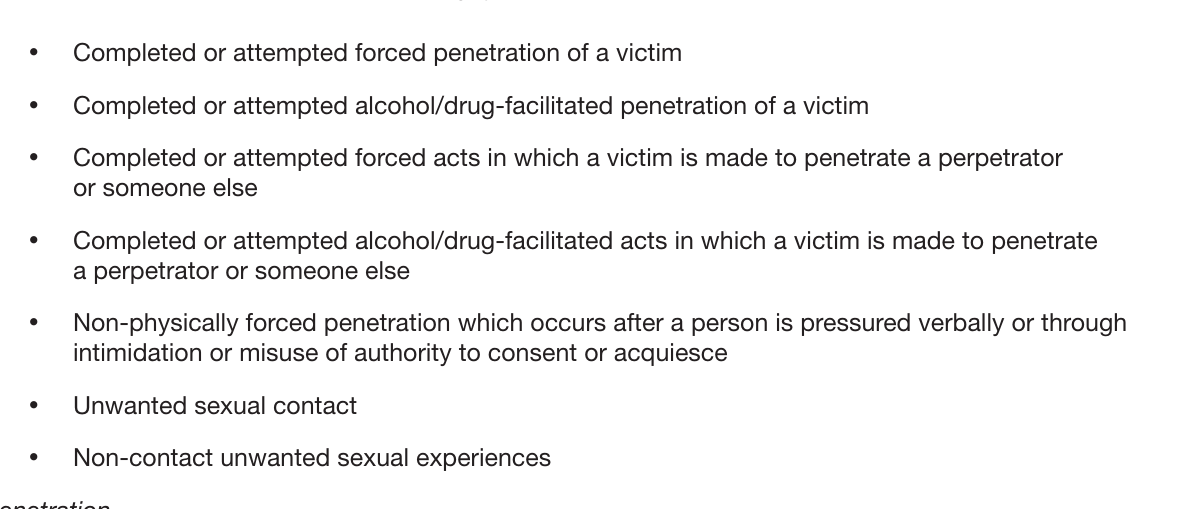
INTIMATE PARTNER VIOLENCE: UNIFORM DEFINITIONS AND RECOMMENDED DATA